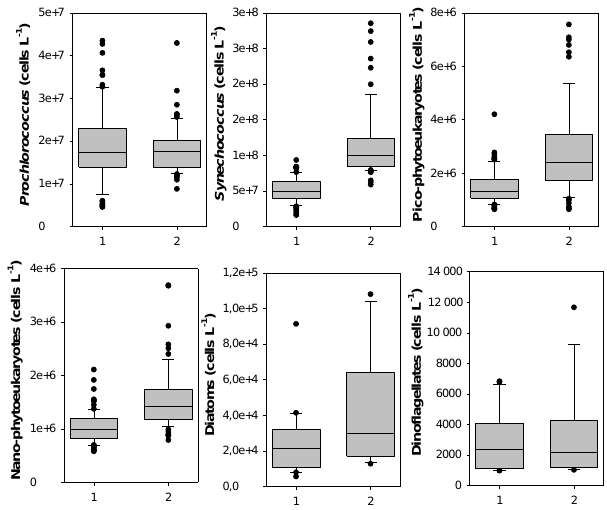
Figure 14. Box plots of the main phytoplanktonic groups in cellsL − 1 in the three mesocosms during the two periods P1 and